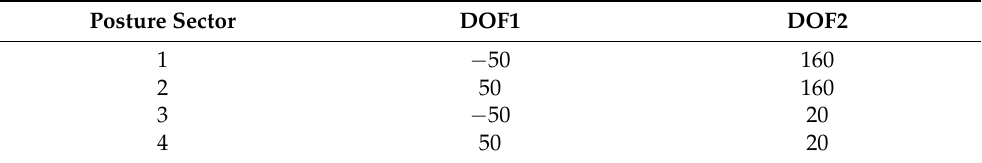
Table 1. Correspondence between the first and second DOFs in posture